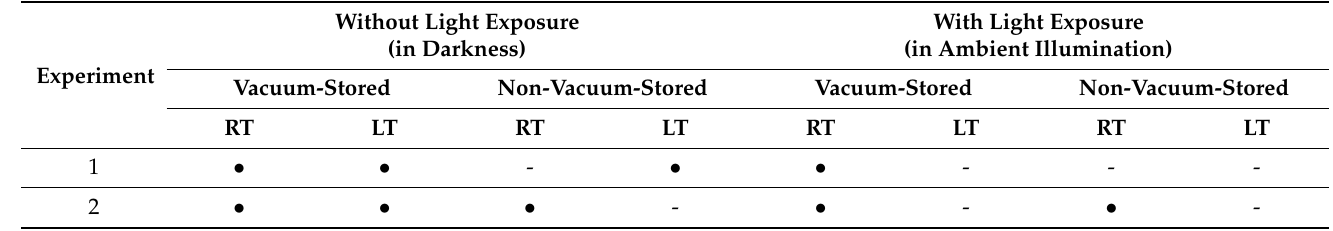
Table 1. List of various experimental storage and location conditions used for the fingernail samples in Experiments 1 and